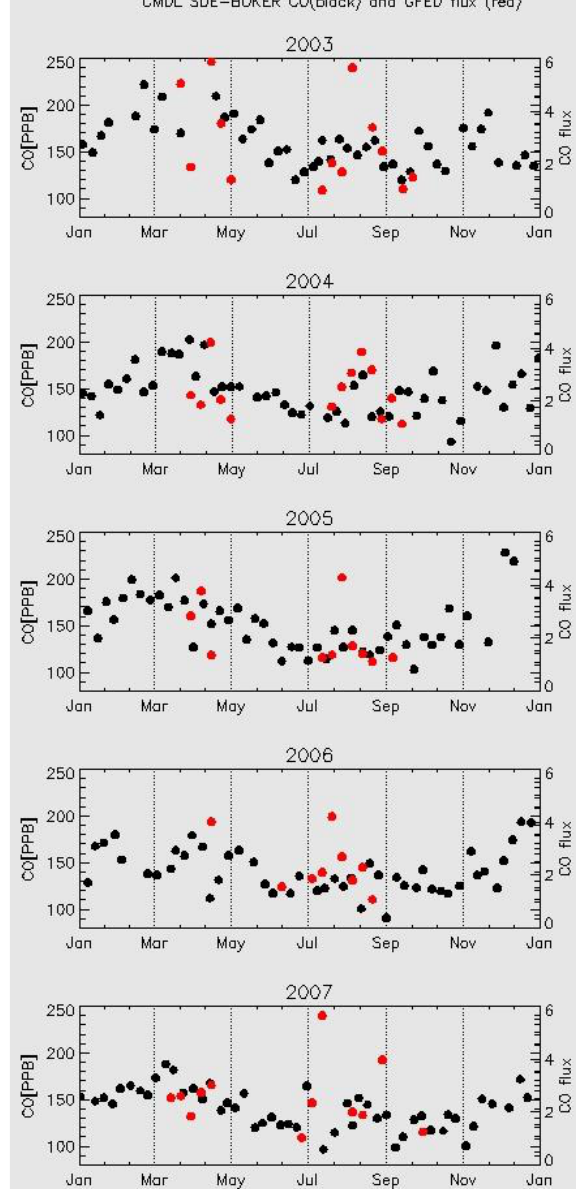
Fig. 15. Local CO surface concentration obtained from NOAA/GMD at Sde-Boker (black circles) and European BB emis- Figure 15. Local CO surface concentration obtained from NOAA/GMD at Sde-Boker sion fluxes [10 13 moleculecm − 2 s − 1 ] calculated from GFED v2 (black circles) and European BB emission fluxes [10 13 molecule cm -2 sec -1 ] calculated (red circles). Local CO enhancement is synchronized with BB fluxes. from GFED v2 (red circles). Local CO enhancement is synchronized with BB fluxes. sian thought, a more ventilated boundary layer over Israel and trajectories coming from north Western Europe. At the second half of August 2007 a strong increase is seen in local contribution and a decrease in west sources contribution. A high pressure system can be seen over most of continental Europe leading to short